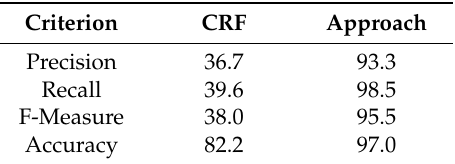
Table 5. Precision, recall, F-measurement and accuracy in % of House C in comparison with the benchmark